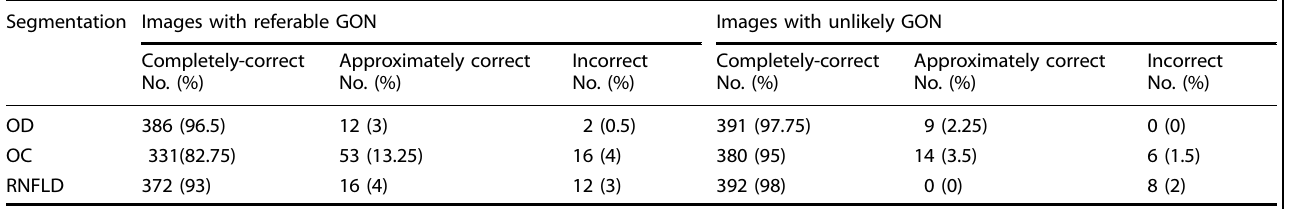
Table 3. Accuracy evaluation of hierarchical deep learning system for OD, OC, and RNFLD segmentation. Segmentation Images with referable